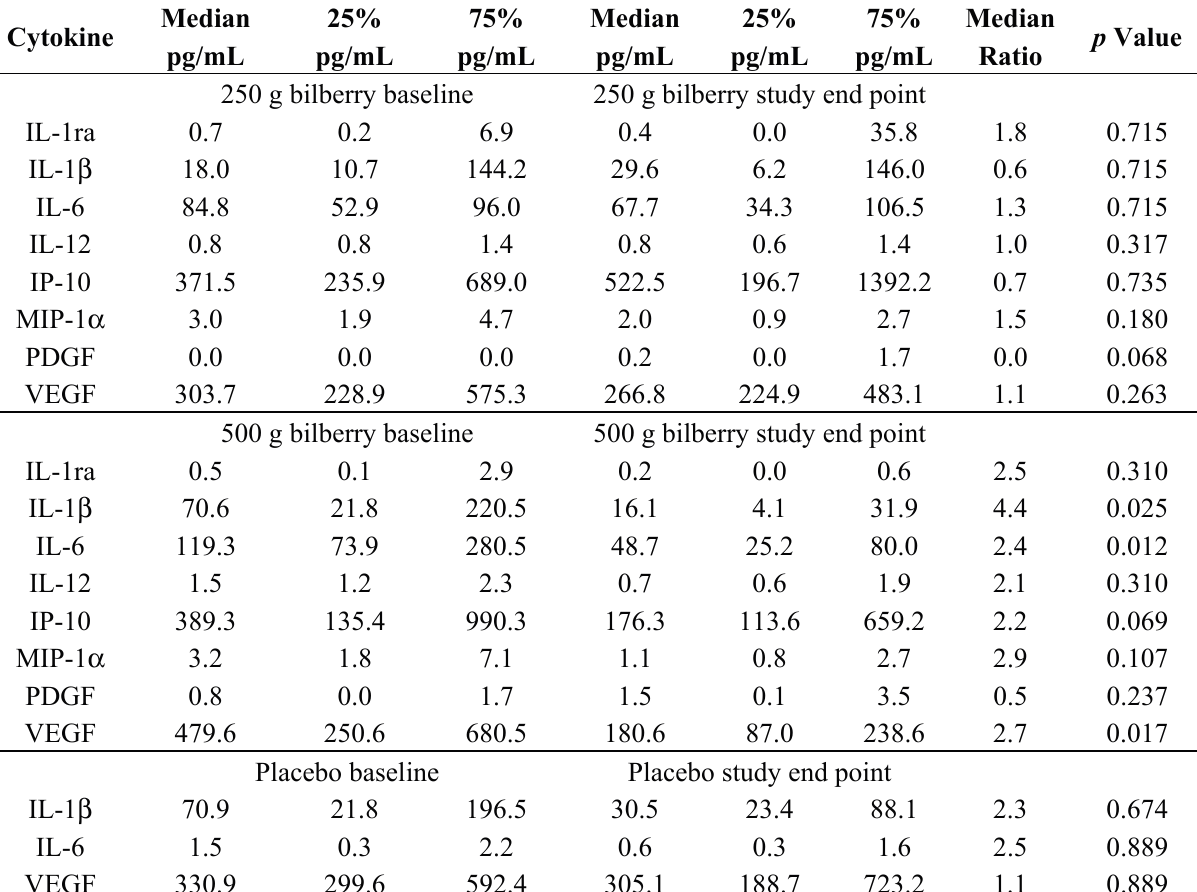
Table 2. Concentrations of IL-1 β , IL-1ra, IL-6, IL-12, MIP-1 α , PDGF, and VEGF in gingival crevicular fluid in the groups that consumed 250 or 500 g bilberries/day or placebo over seven days. Data are presented for median values, 25th and 75th percentile due to non-normal distribution. Exact p -values are